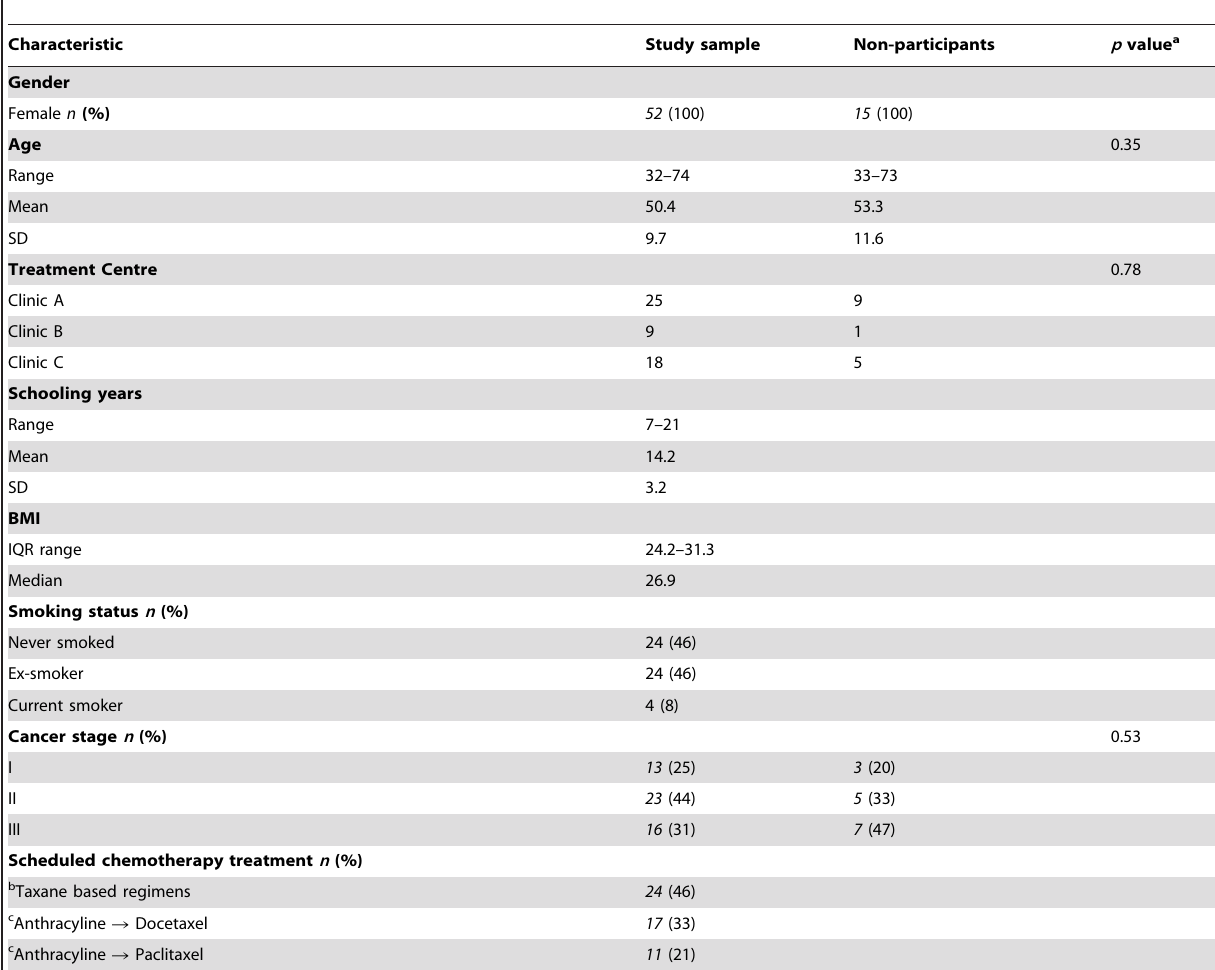
Table 1. Demographic, clinical and social characteristics of study participants and non-participants at